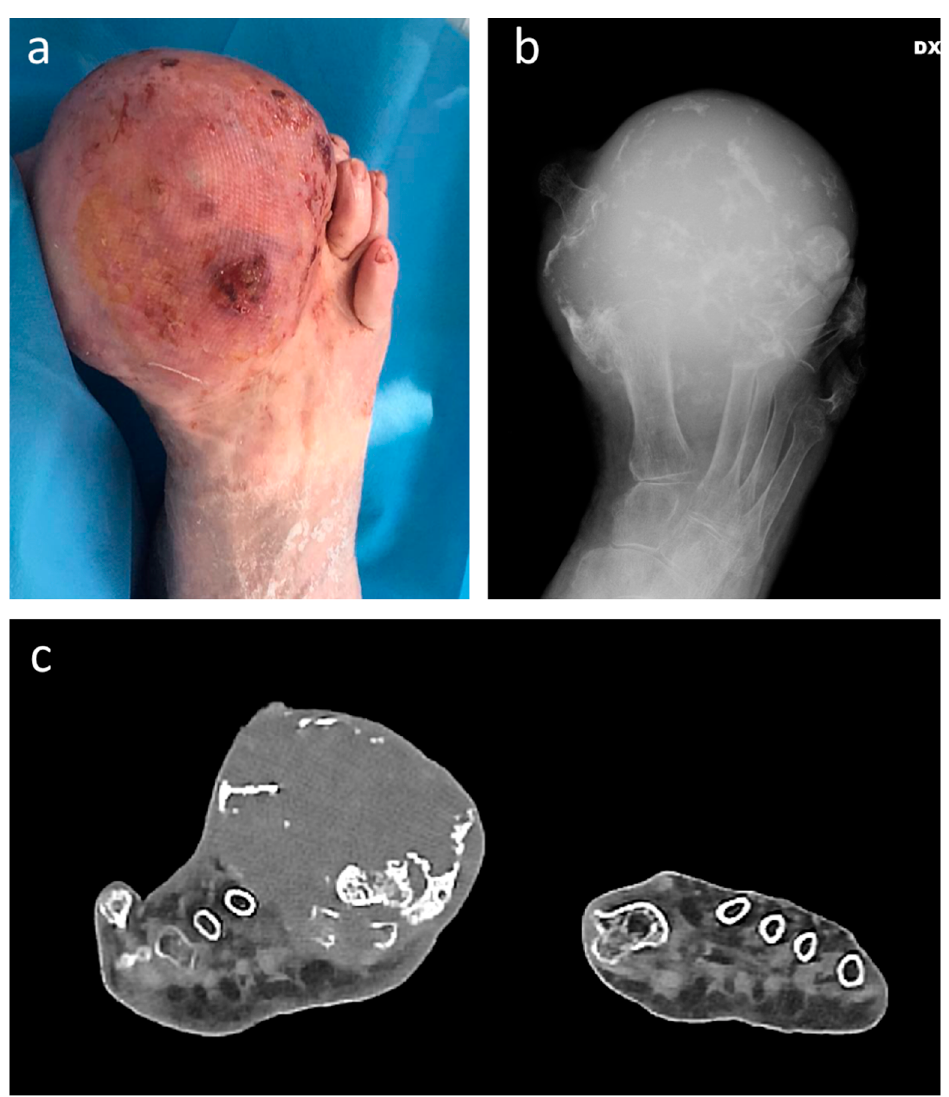
Figure 1. Clinical ( a ), plain radiograph ( b ), and coronal CT scan ( c ) appearance of gr. 2 chondrosar- coma in a 95-year-old female patient, appearing as swelling gradually increased over the last 15 years. A below-knee amputation was performed.